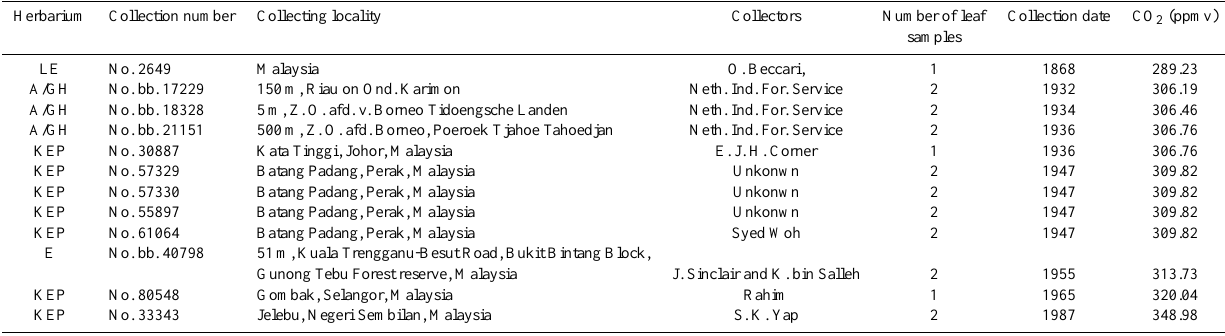
Table 1. Modern Nageia motleyi (Parl.) De Laub. samples and atmospheric CO 2 values of their collection dates from ice core data (Brown, 2010).